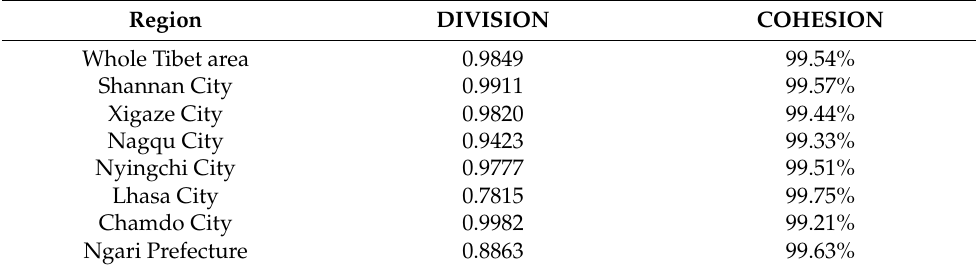
Table 4. DIVISION and COHESION Index of residential patches in Tibet. Region